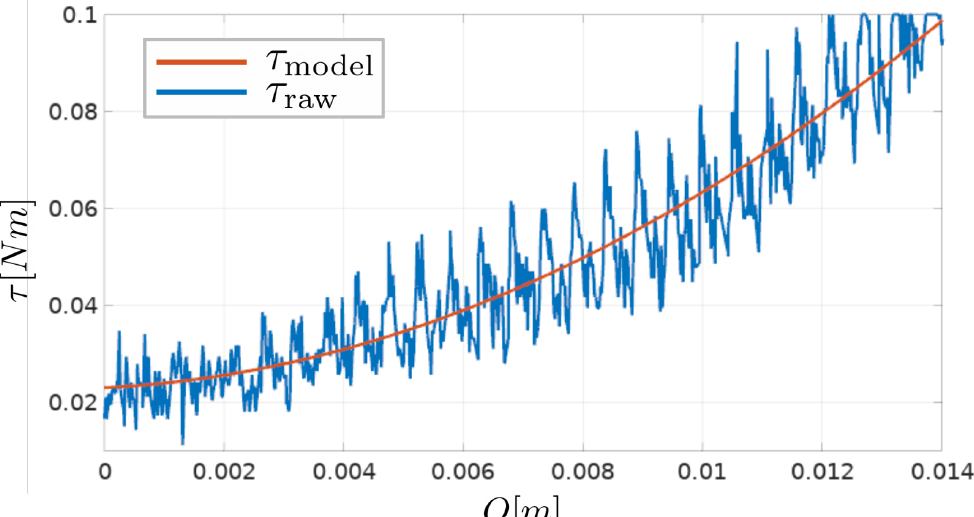
Figure 6. Experimental results suggest that the relationship between the overlap and the measured torque can be approximated with a quadratic function. Raw measurements of the torque applied by the tool τ raw and the fitted quadratic function model τ model are